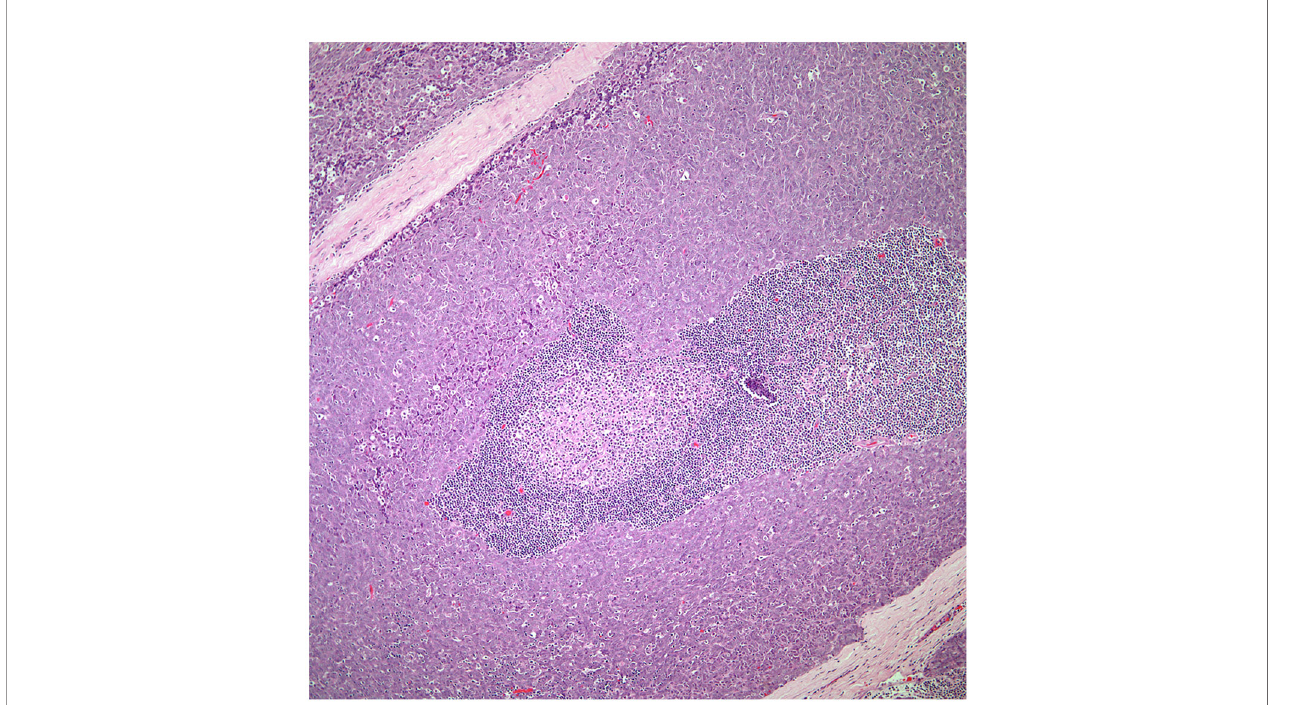
FIGURE 4 | Low power view of a micronodular thymic carcinoma with B-cell lymphoid hyperplasia, note the presence of a germinal center.